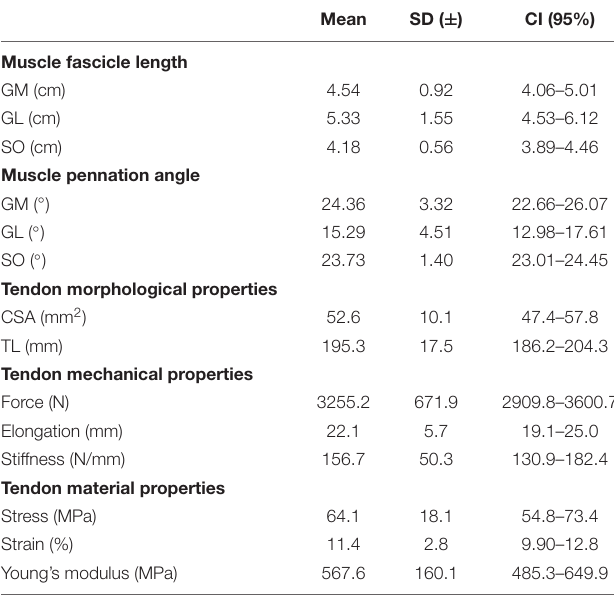
TABLE 2 | Muscle architecture parameters and Achilles tendon’s morphological, mechanical, and material properties in mean, standard deviation (SD), and confidence interval